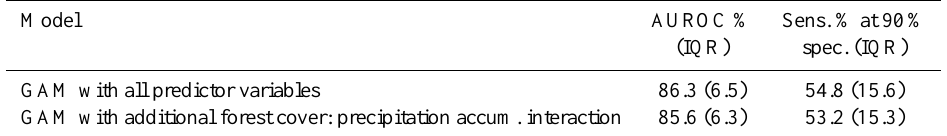
Table 7. Median (and IQR) model performance values measured by AUROC and sensitivity at 90% specificity estimated from spatial